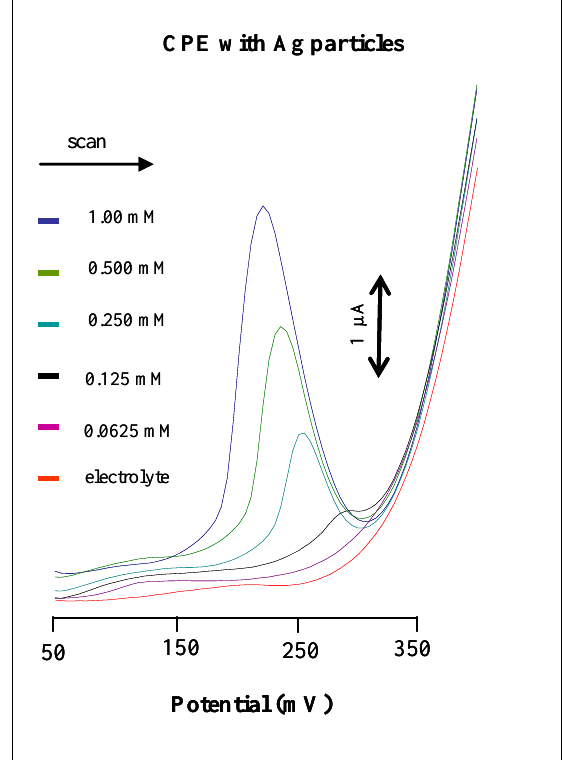
Figure 3. Electrochemical analysis of chloride ions using CPE modified by